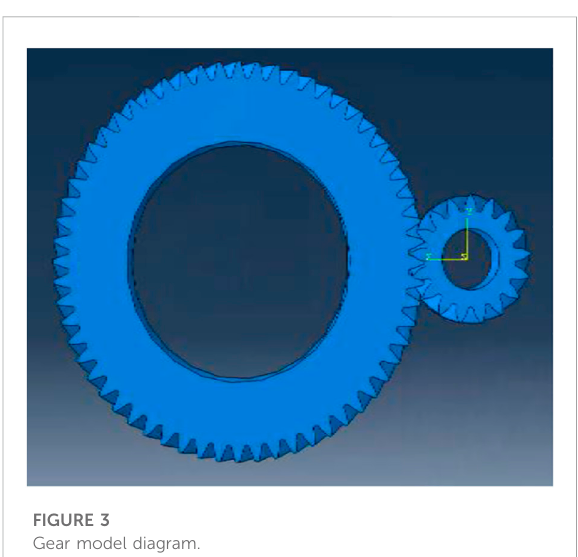
FIGURE 3 Gear model